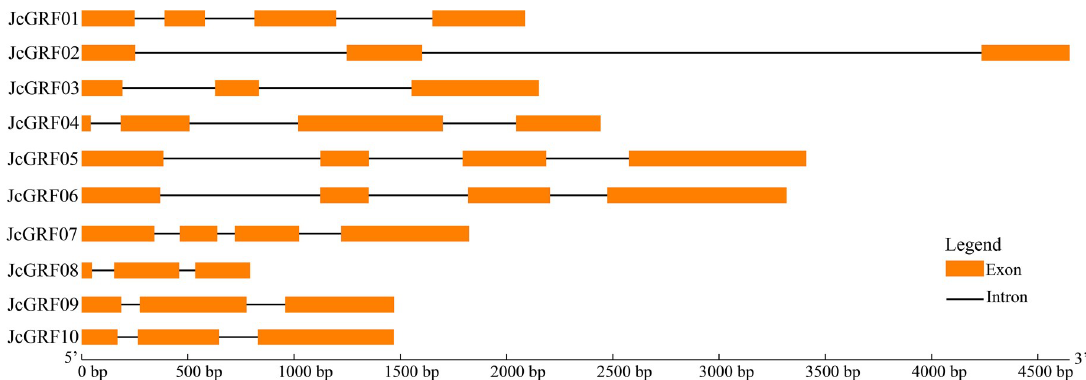
Fig 2. Gene structure in JcGRF genes from Jatropha curcas . Exons and introns are shown as light orange boxes and thin lines respectively.